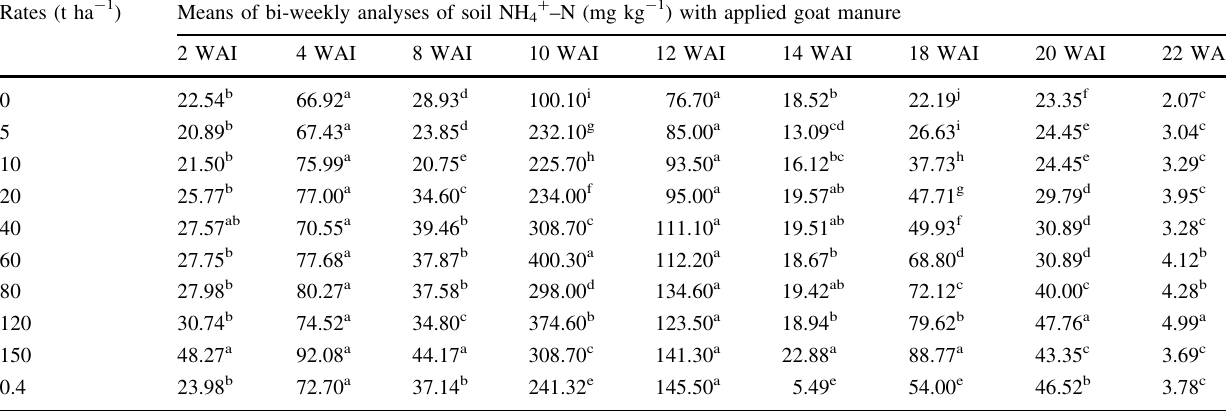
Table 6 Influence of goat manure rates and NPK fertilizer (t ha - 1 ) on mean soil NH 4 ? –N (mg kg - 1 ) at 2 weeks intervals Rates (t ha - 1